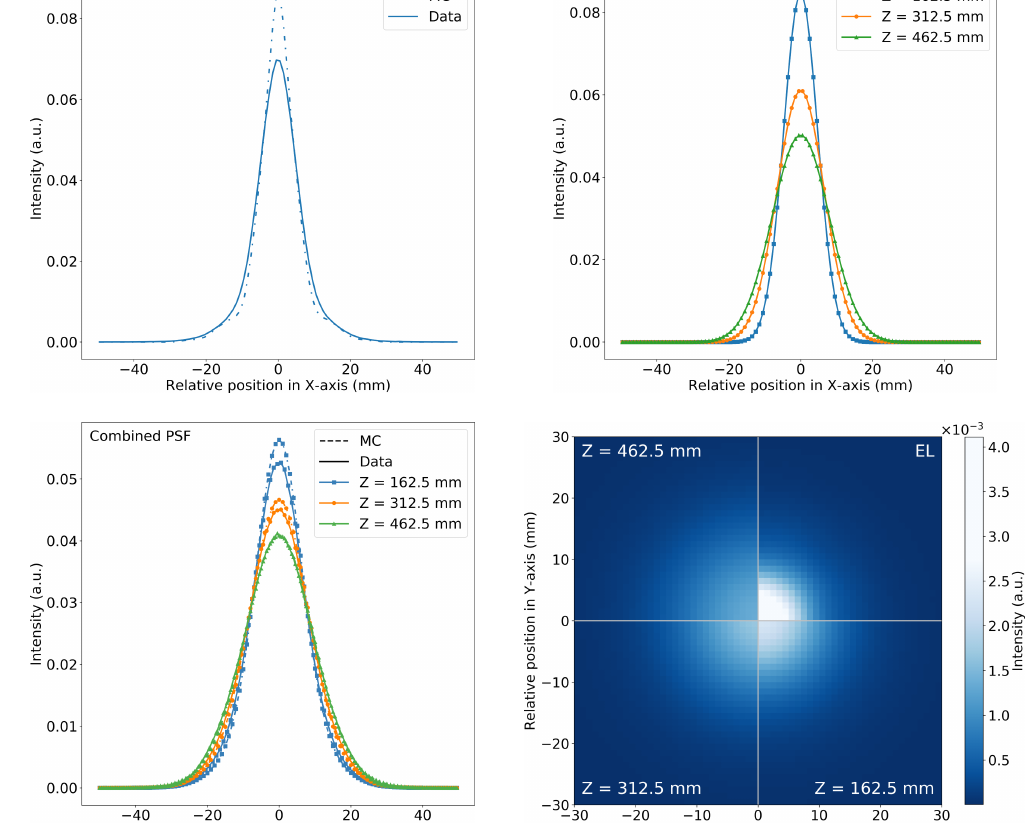
Figure 4 . Top left: EL PSF (from 83 m Kr data and Monte Carlo). Top right: the 2D transverse diffusion PSF (calculation based on the diffusion measurements in [43]). Bottom left: the combined EL+diffusion PSF. Experimental data (solid line) are from 83 m Kr events selected by their drift distance, while MC (dashed lines) is a convolution of the EL PSF and the 2D transverse diffusion PSF. Bottom right: the 2D PSF for experimental data for the different drifts shown in the accom- panying plots, along with the 2D EL PSF in the first quadrant. The intensity value refers to the area-normalized value of the